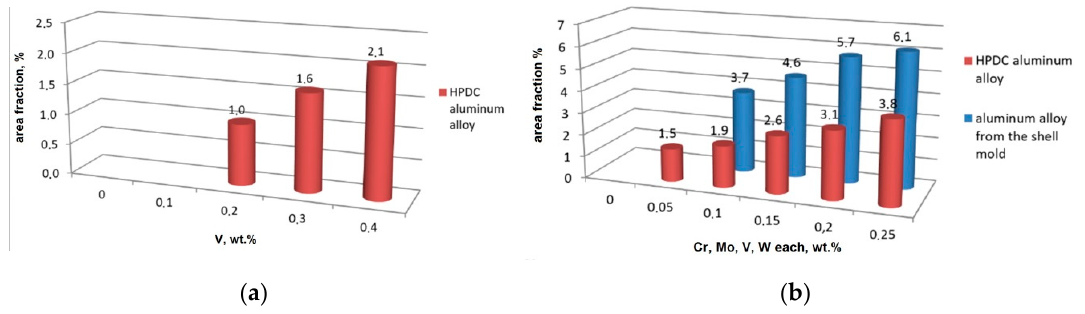
Figure 16. Changes in the area fraction of the primary Al 15 (Fe,Mn,M) 3 Si 2 phase in a Al-Si alloy containing vanadium ( a ) and simultaneously Cr, Mo, V, and W ( b ).